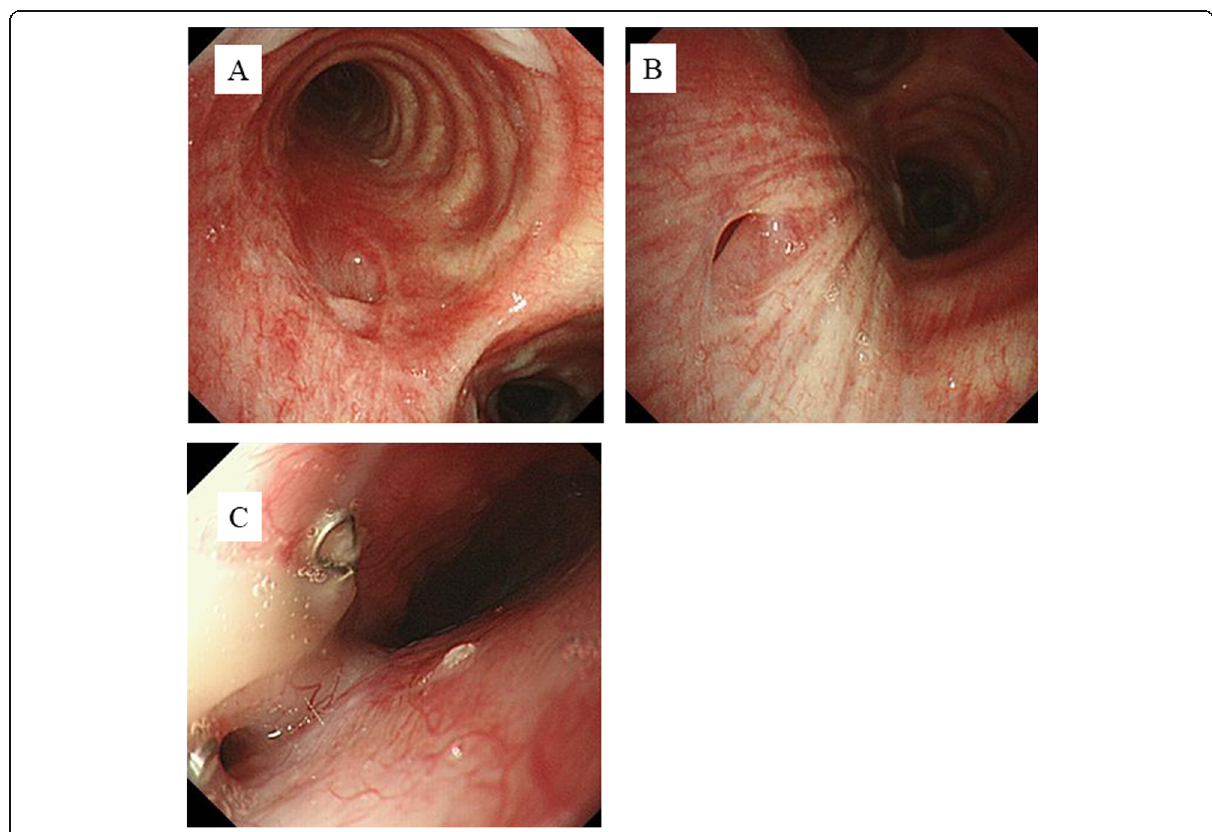
Fig. 2 Bronchoscopy revealed that the GBF was covered by mucosa and was cured ( a ). Bronchoscopy revealed that the GTF was located in the trachea, 3 cm above the carina ( b ). Esophagogastroduodenoscopy showed the GTF located in the left wall at the anastomosis ( c